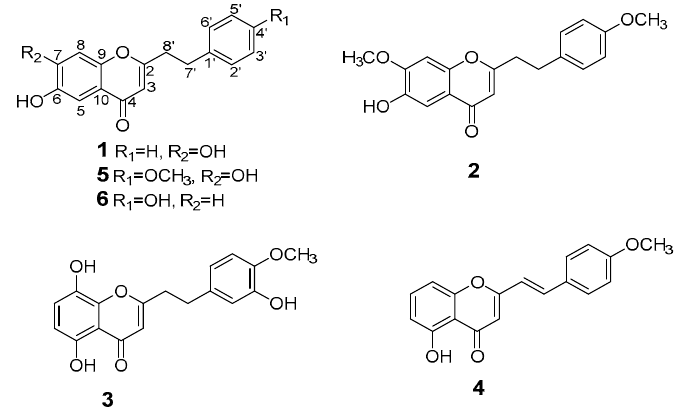
Figure 1. Chemical structure of compounds 1 – 6 .